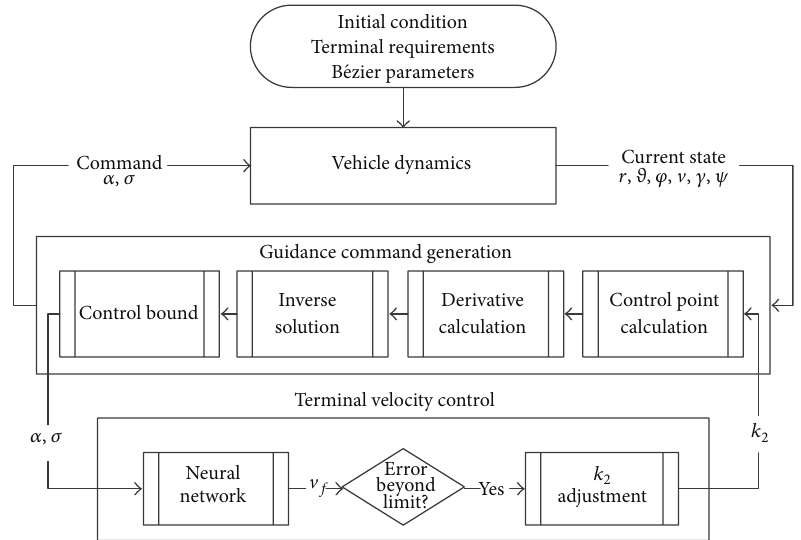
Figure 8: Guidance law implementation.